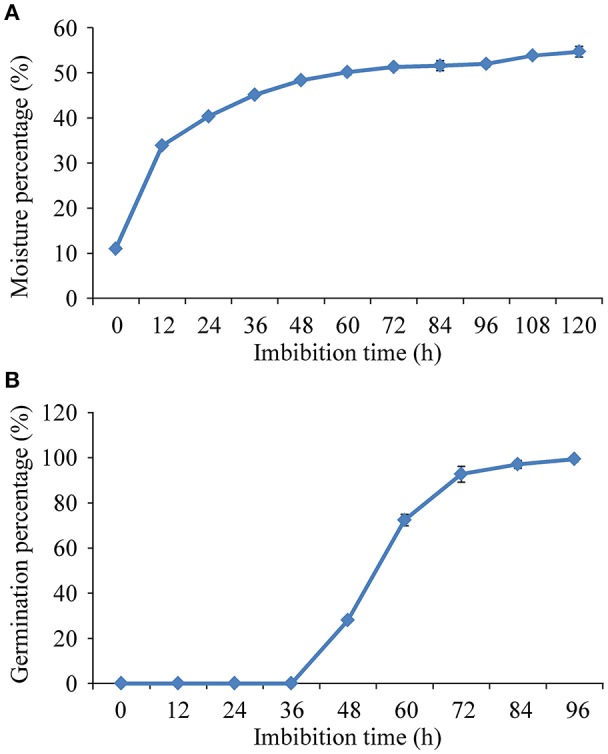
Triphasic pattern of water uptake (A) and changes of germination percentage (B) under 150 mM NaCl condition in rice.